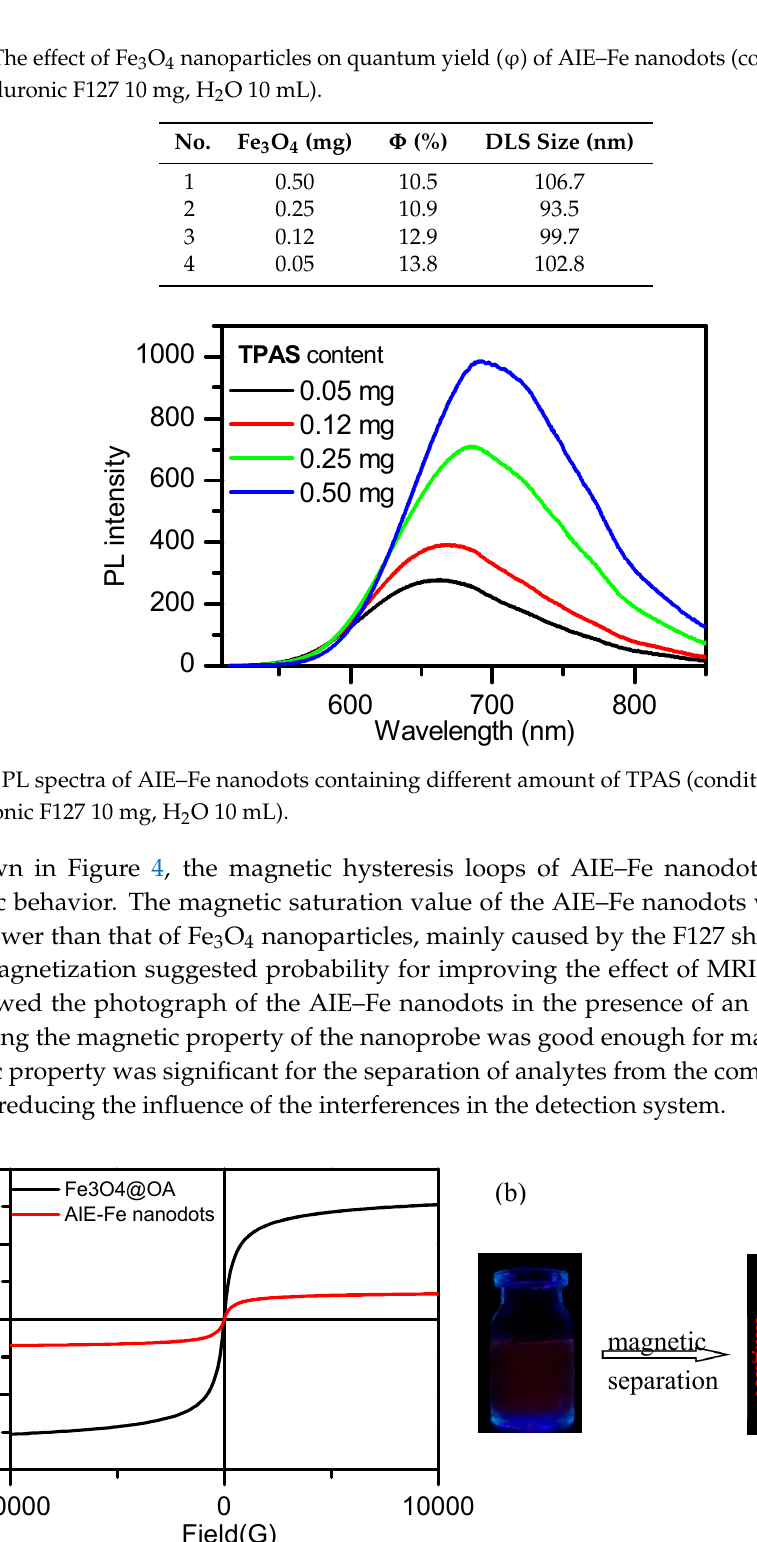
Table 1. The effect of Fe 3 O 4 nanoparticles on quantum yield ( φ ) of AIE–Fe nanodots (conditions: TPAS 0.5 mg, Pluronic F127 10 mg, H 2 O 10 mL).